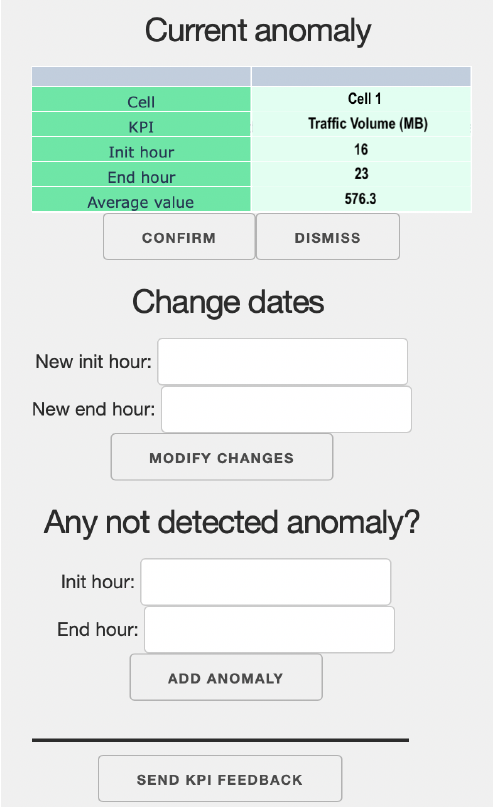
Figure 3. Example of graphics shown to an